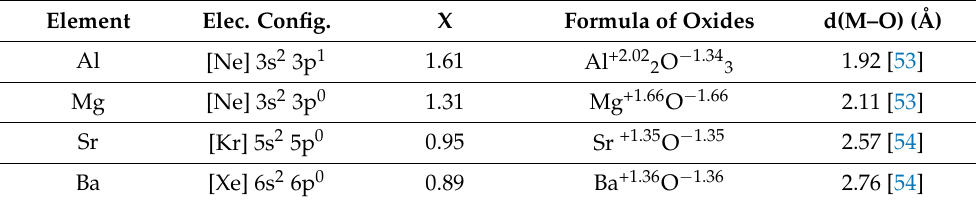
Table 1. Electronic configurations and electronegativity, χ , of the alkaline earth elements Mg, Sr and Ba, as well as Al. These elements have s, p valence electrons. The (averaged) bond lengths between the metals and oxygen in their oxides, MgO, SrO, and BaO of the NaCl-type structure, as well as α -Al 2 O 3, with a trigonal lattice, as discussed in the literature [53,54], are included. Charges at the atomic sites from present calculations are shown in the